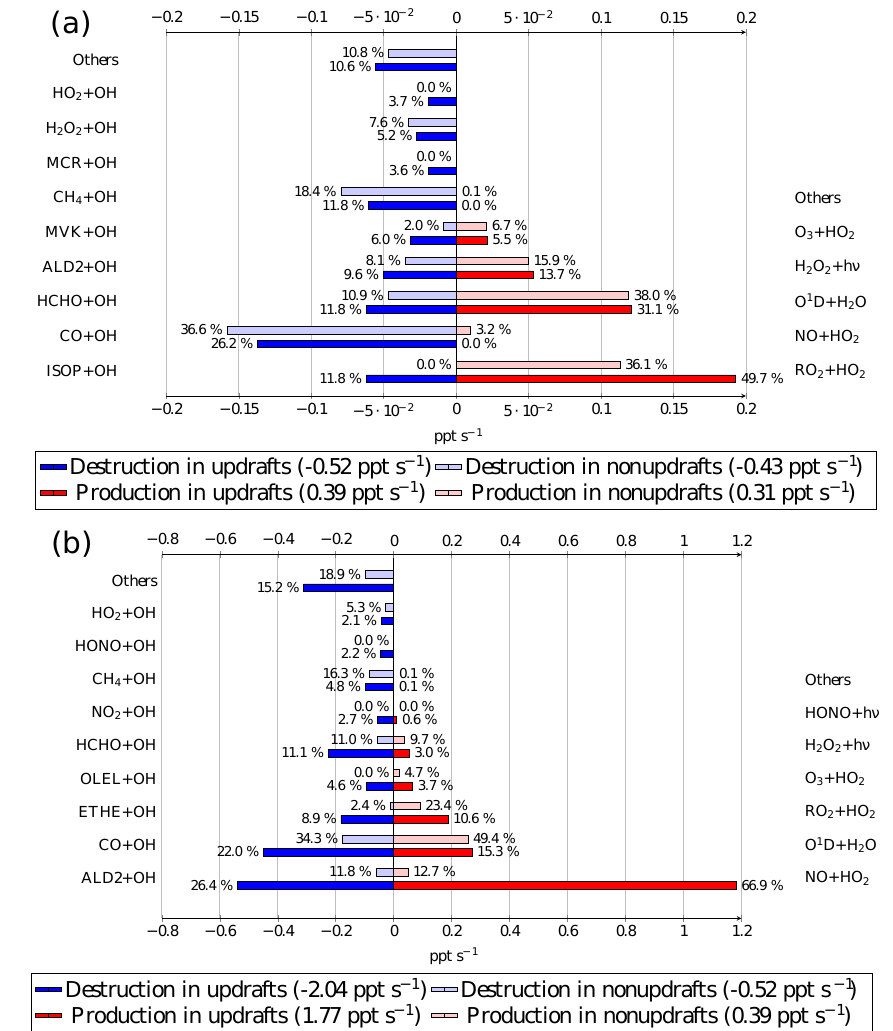
Figure 8. Same as Fig. 7 for the height of 1200m.